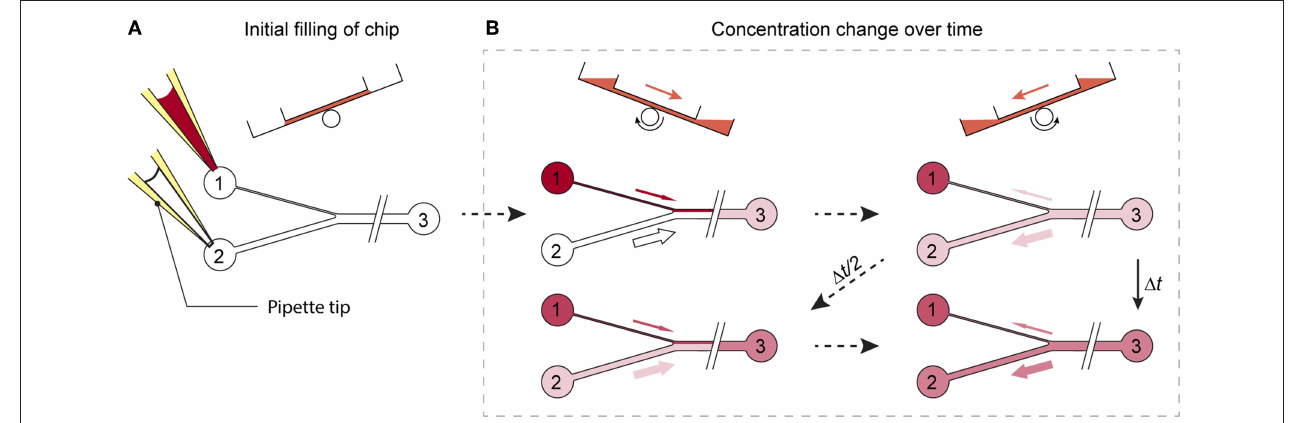
FIGURE 2 | Working principle of the design. (A) Reservoirs 1 and 2 are filled with substance-loaded and plain cell culture medium. (B) Upon tilting of the chip, unequal volumes of liquid flow through the differently sized channels. While the substance concentration is, with each tilting interval ∆ t , gradually enriched in reservoirs 2 and 3, the substance is diluted in reservoir 1, until a concentration equilibrium is